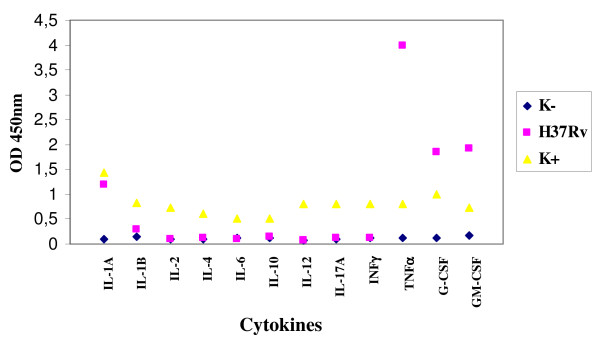
Expression of cytokines by enteric glial cells MIM/PPK infected by M. tuberculosis H37Rv.